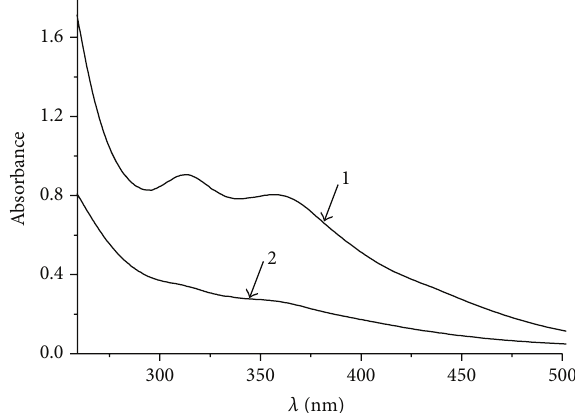
Figure 3: Spectra of 10 −4 M ( I ) in 0.05 M phosphate buffer, pH 7.0 makeup (1) and after 18 hours at 25 ∘ C (2) . Extinction at 𝜆 = 312 nm is equal to 9.1 ⋅ 10 3 M −1 cm −1 and 2.6 ⋅ 10 3 M −1 cm −1 at 450 nm. ( I ) is the complex [ Fe 2 ( SC 5 H 11 NO 2 ) 2 ( NO ) 4 ] SO 4 ⋅ 5 H 2